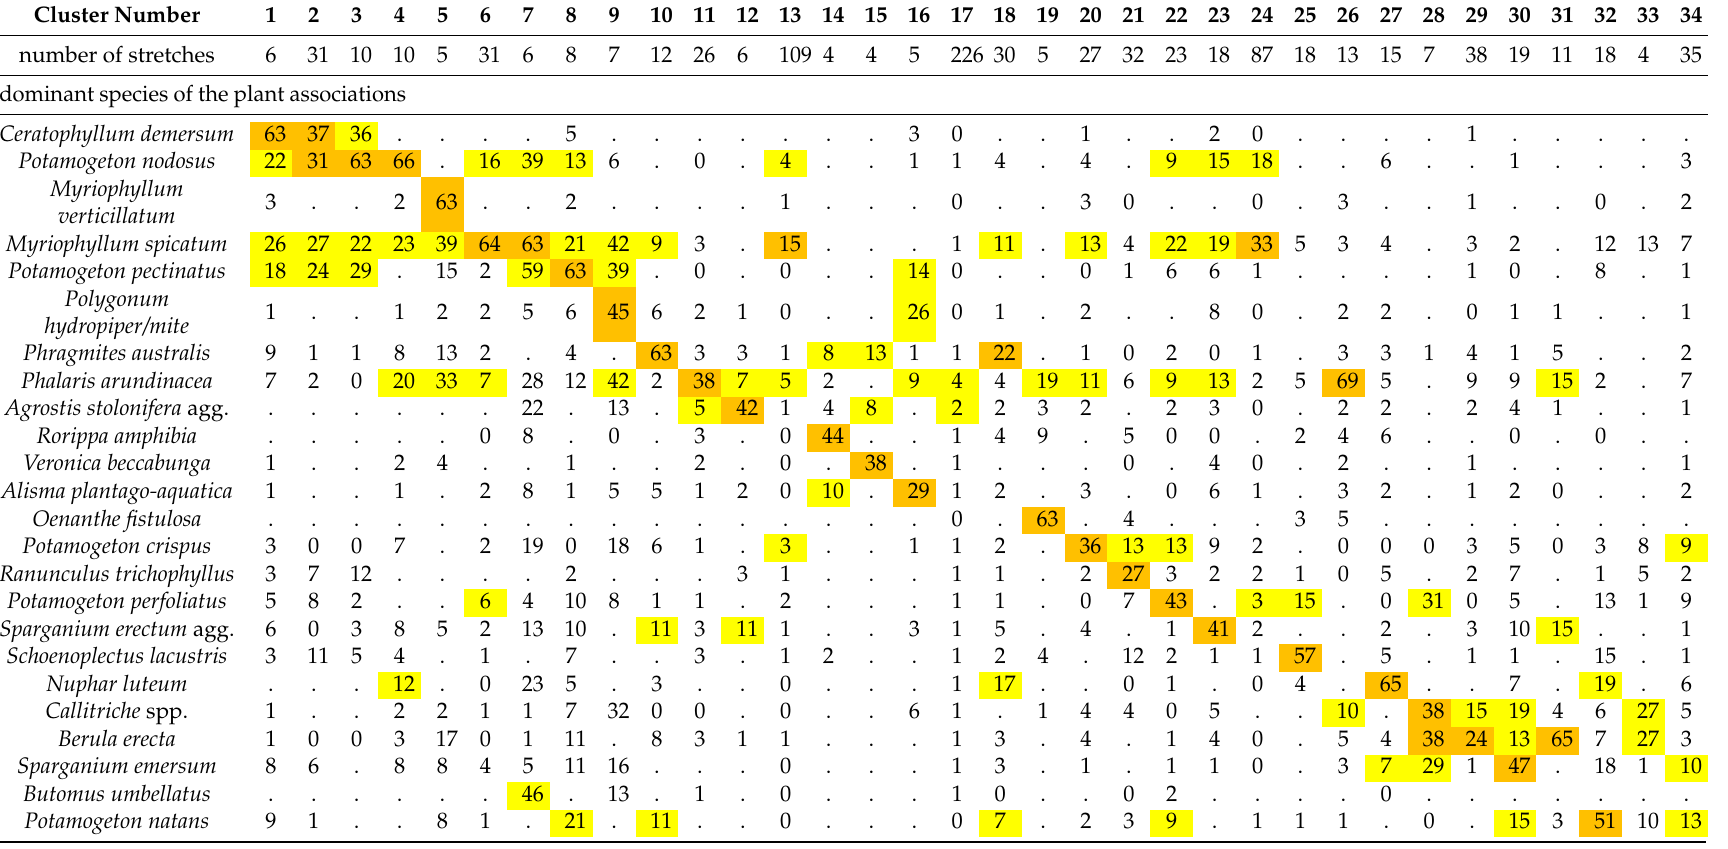
Table A1. Synoptic table of the clusters classified into plant communities. Their dominant (orange) and subdominant (yellow) species are presented in average values of cover-abundance values (%). 0 stands for values